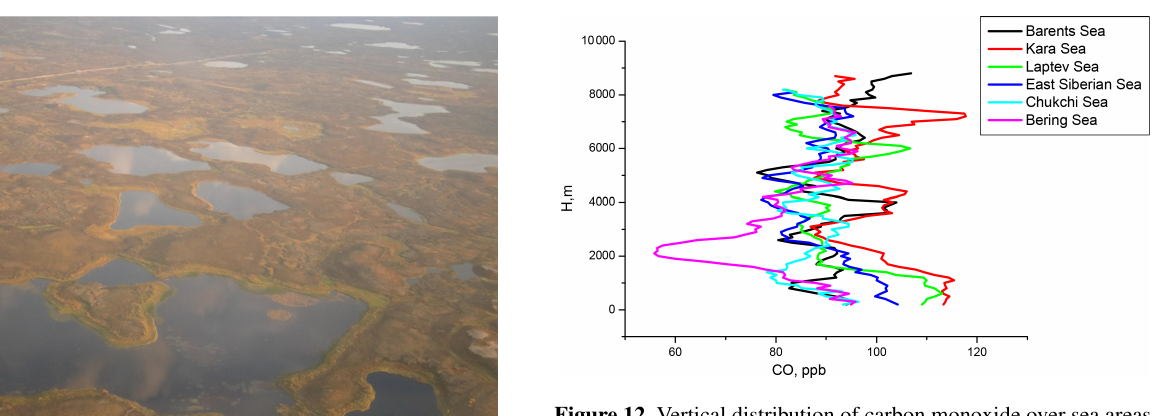
Figure 12. Vertical distribution of carbon monoxide over sea areas.